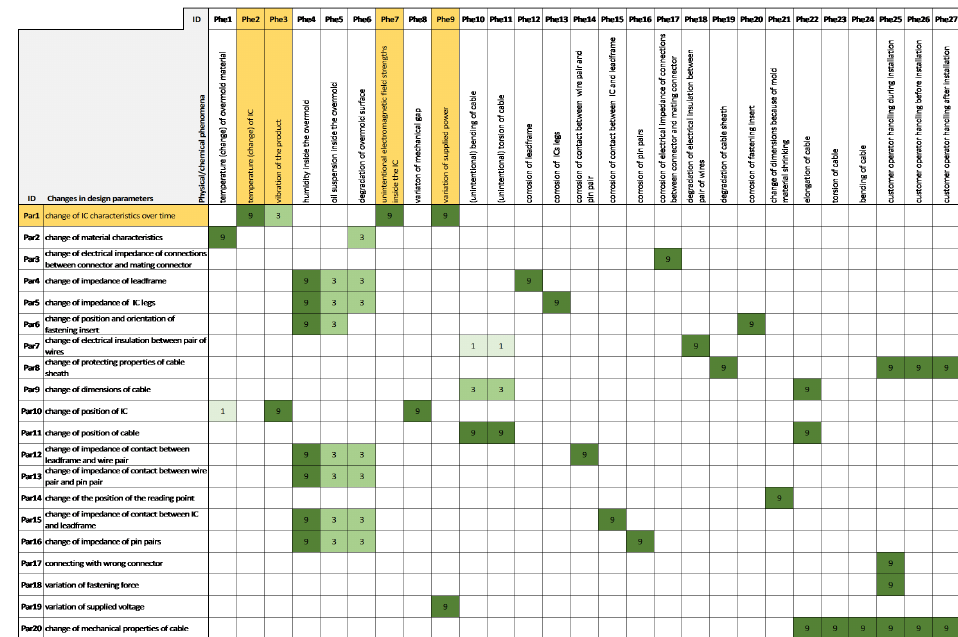
Figure 8. House of Phenomena: this is the second House of Noises: Changes in design parameters vs. Physical/chemical phenomena. The House of Phenomena connects the direct causes from the House of Design Parameters (output of the House of Design Parameters) to its direct